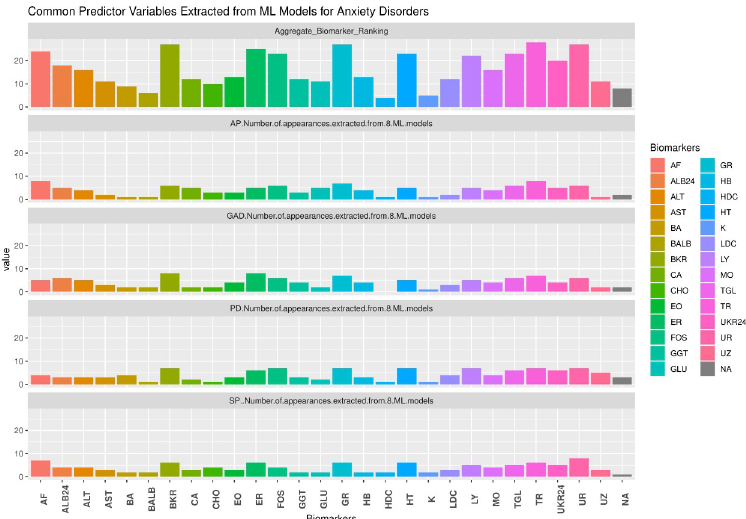
Fig 3. Common predictor variables extracted from ML models for anxiety disorders. Authors’ own